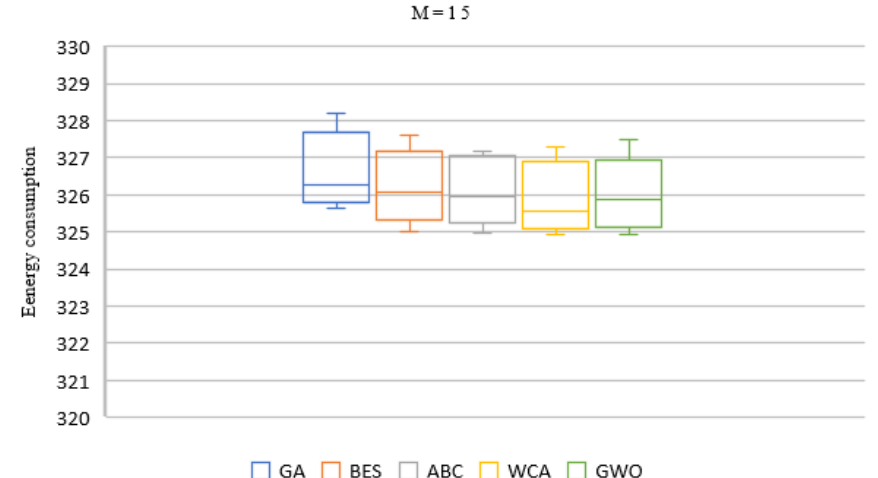
Figure 11. Box plot of the objective function at an initial population of 5.